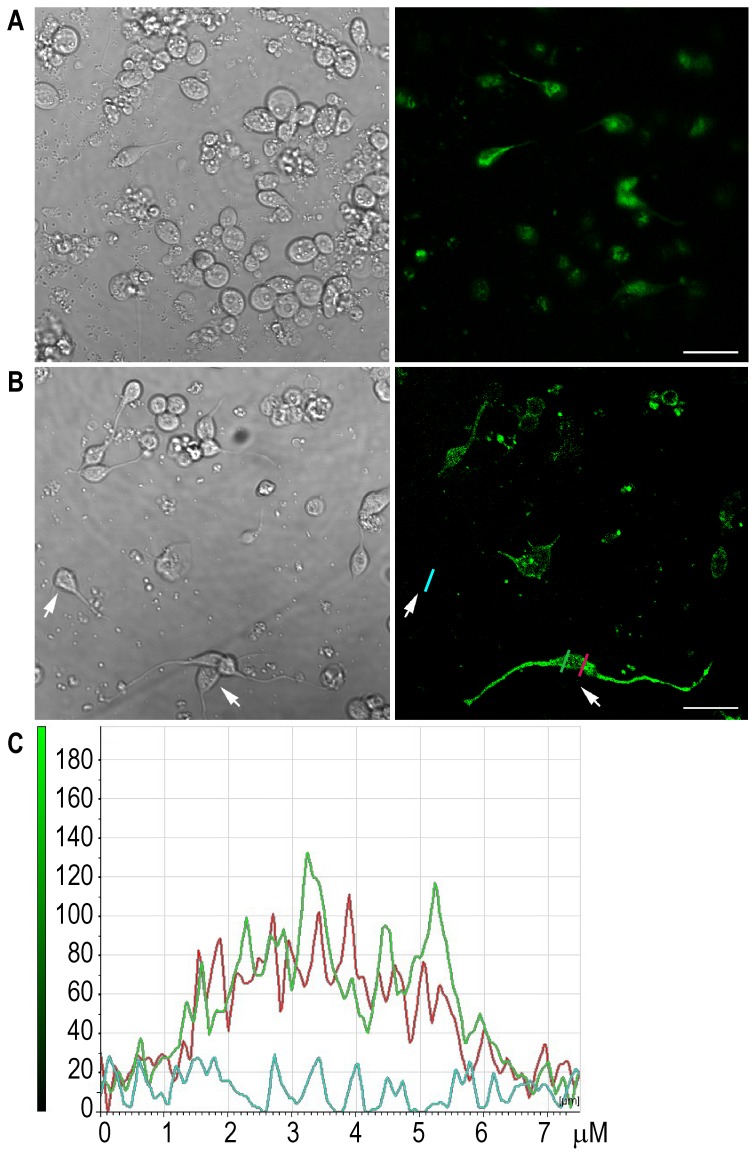
Expression of GABA receptor in C. elegans muscle cultured cells.Confocal microscopy of L1 muscle cells in culture from worms expressing GFP in muscle (PD4251 strain, (A)) or associated to GABA receptors (EG1653 strain, (B)). Left panels correspond to DIC and Right panels correspond to fluorescence microscopy. Bar: 20 µm. (C) Fluorescence intensity profile at the membrane level of representative cells shown in panel B, two of which show GFP expression (marked by green and red lines) and the other corresponds to the basal fluorescence (blue line).